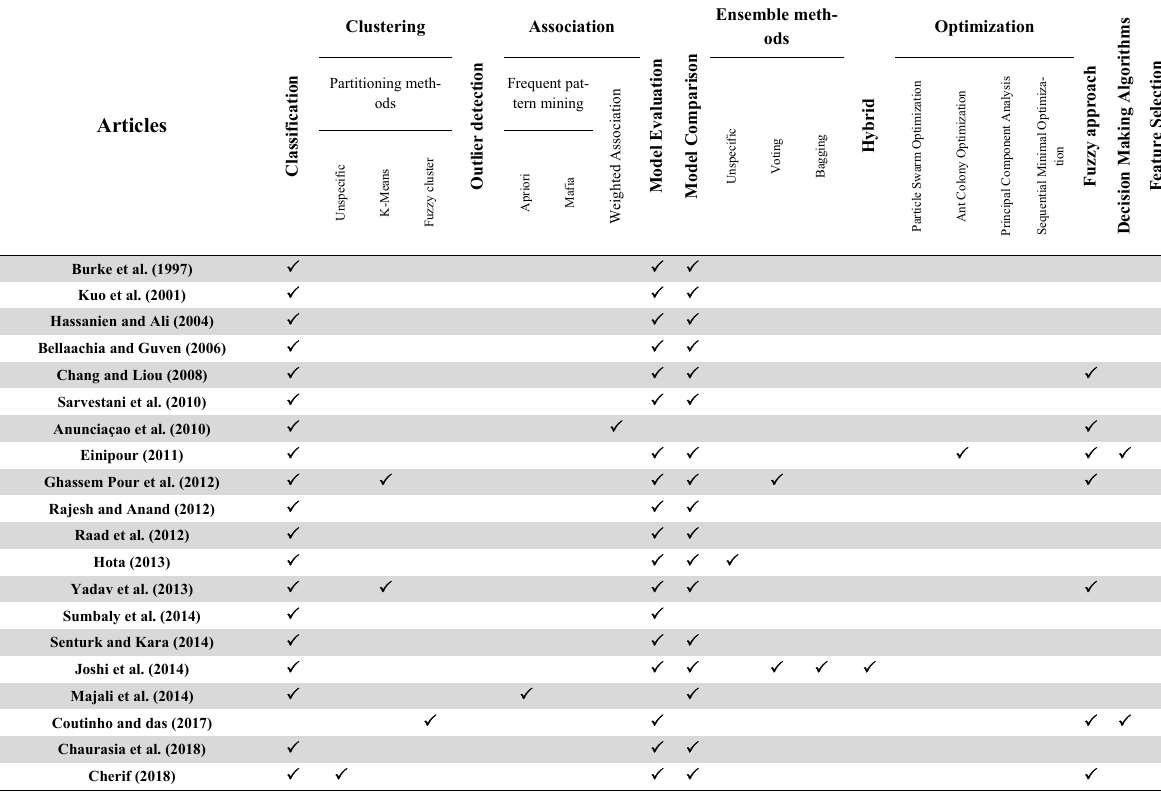
The overall review of the data mining techniques in breast cancer diagnosis